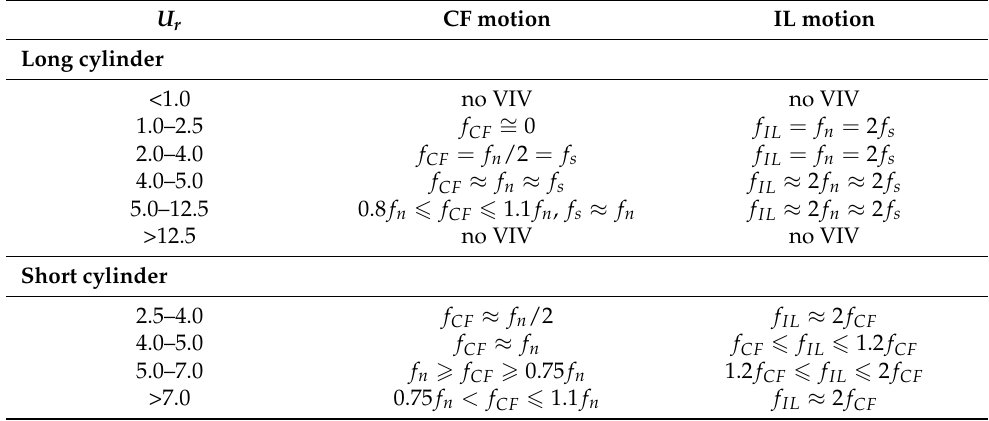
Table 1. Qualitative behaviour for the response frequencies of long and short cylinders ( f CF : cross- flow; f IL : in-line; f s = StU / D : vortex-shedding frequency). Adapted from [11]. U r CF motion IL